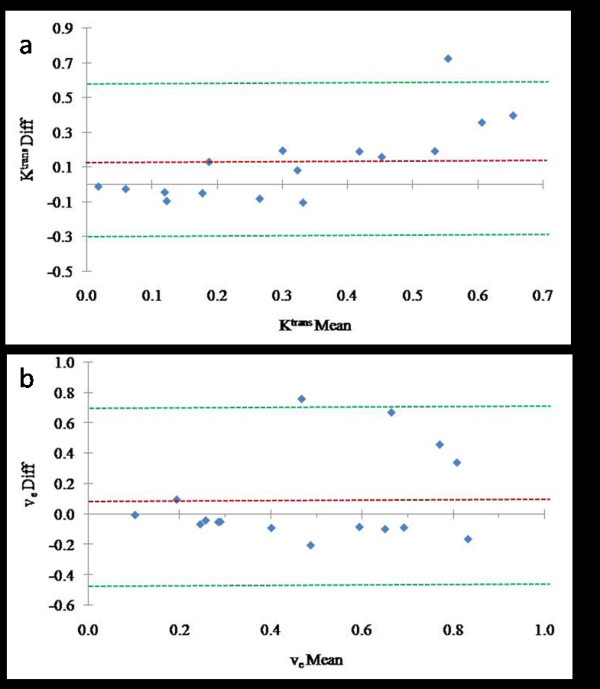
Bland-Altman plots showing variability of the differences between parameter estimates obtained by the two methods. Horizontal axes are means and vertical axes are the differences of the paired estimates. Dotted references lines show bias and limits of agreement (mean of differences +/- 2 SD of differences). (a) Ktrans Ind-AIF – KtransAvg-AIF (0.124 +/- .448); (b) ve Ind-AIF – veAvg-AIF (0.088 +/- .600).